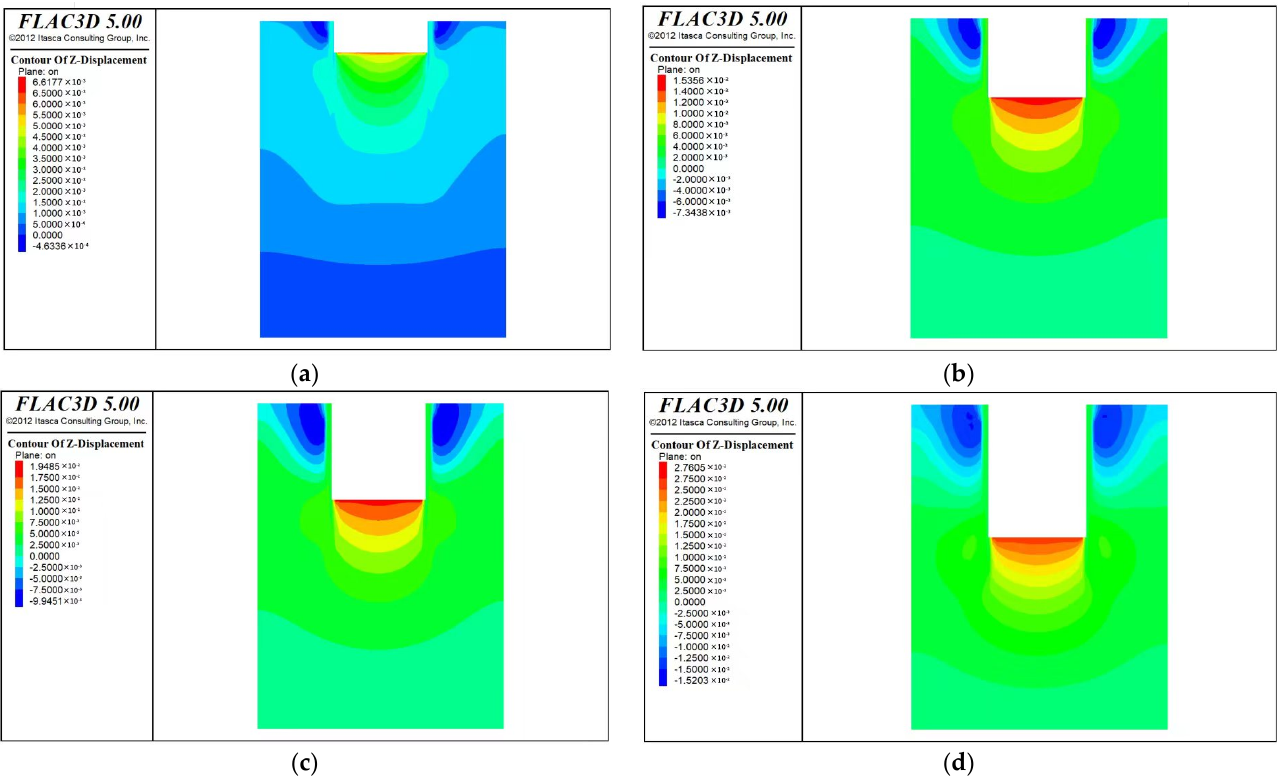
Figure 11. Horizontal displacement nephograms of each working condition. (a) excavation to a level 0.5m below the second support; (b) excavation to a level 0.5m below the third support; (c) excavation 0.5m below the second support; ( b ) excavation to a level 0.5m below the third support; ( c ) excavation to a level 0.5m below the fourth support; (d) excavation to the pit bottom. to a level 0.5m below the fourth support; ( d ) excavation to the pit